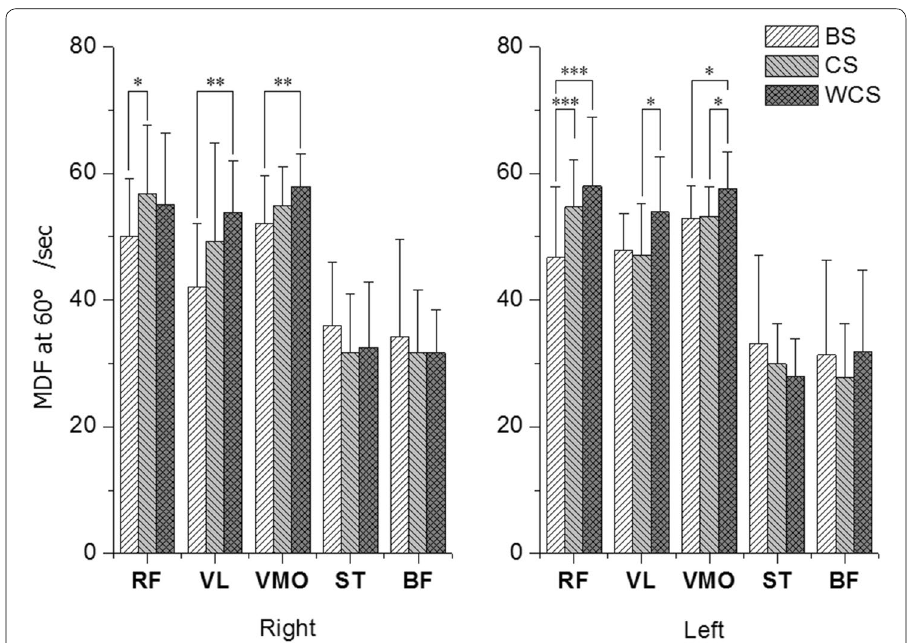
Fig. 9 MDF at the angular velocity of 60°/s: left is for the left leg; right is for the right